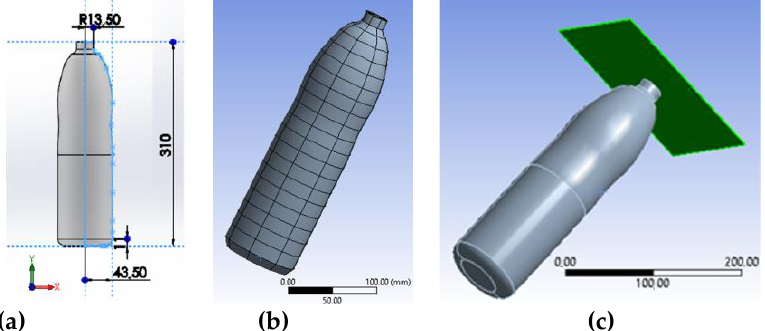
Figure 12. Finite Element modeling by solid elements: ( a ) 3D bottle model; ( b ) tetrahedral mesh; ( c ) boundary conditions.